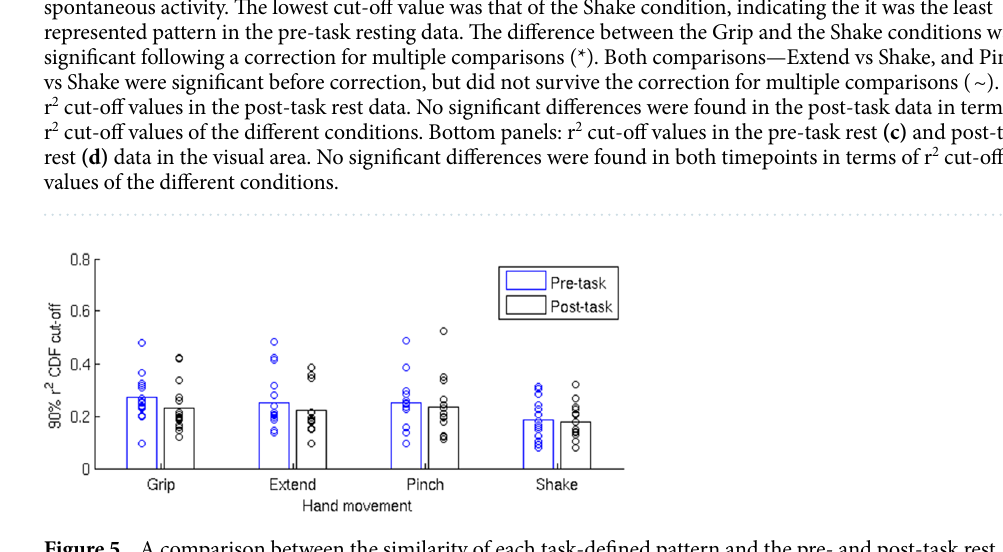
the changes between the pre- and post-task rest similarity with the task patterns resulted from decreased similarity of the post-task rest to the Grip (t(14) = 3.28, p = 0.006, significant after correction) and to the Extend (t(14) = 2.57, p = 0.022, approaching significance) conditions relative to the pre-task rest. Pattern similarity analysis using Pearson r values.